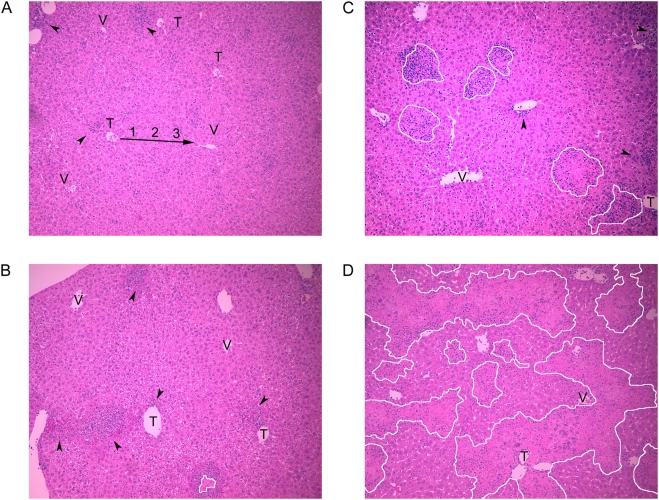
Extensive liver necrosis occurred in C3-deficient mice.Liver samples were taken from mice 7 days after infection with ∼700 pfu via ear pinna, fixed, sectioned, and stained with hematoxylin and eosin. Representative images show the range of differences between the strains. White lines border coalesced areas of necrosis. Arrowheads point to non-necrotic inflammatory foci. T, portal triad; V, central vein. (A) Wild-type—blood flows through the liver from zone 1 to 3, as indicated by the arrow. Zone 1 encircles the portal triad, zone 3 encircles the central vein, and zone 2 occurs between zones 1 and 3. There are small inflammatory foci adjacent to two portal triads. (B) Wild-type—there are inflammatory foci adjacent to portal triads, and one focus has a small area of confluent necrosis. (C) C3−/−—larger inflammatory foci with areas of confluent necrosis. (D) C3−/−—an inflammatory infiltrate borders the extensive necrosis that bridges across all three zones (T→V).